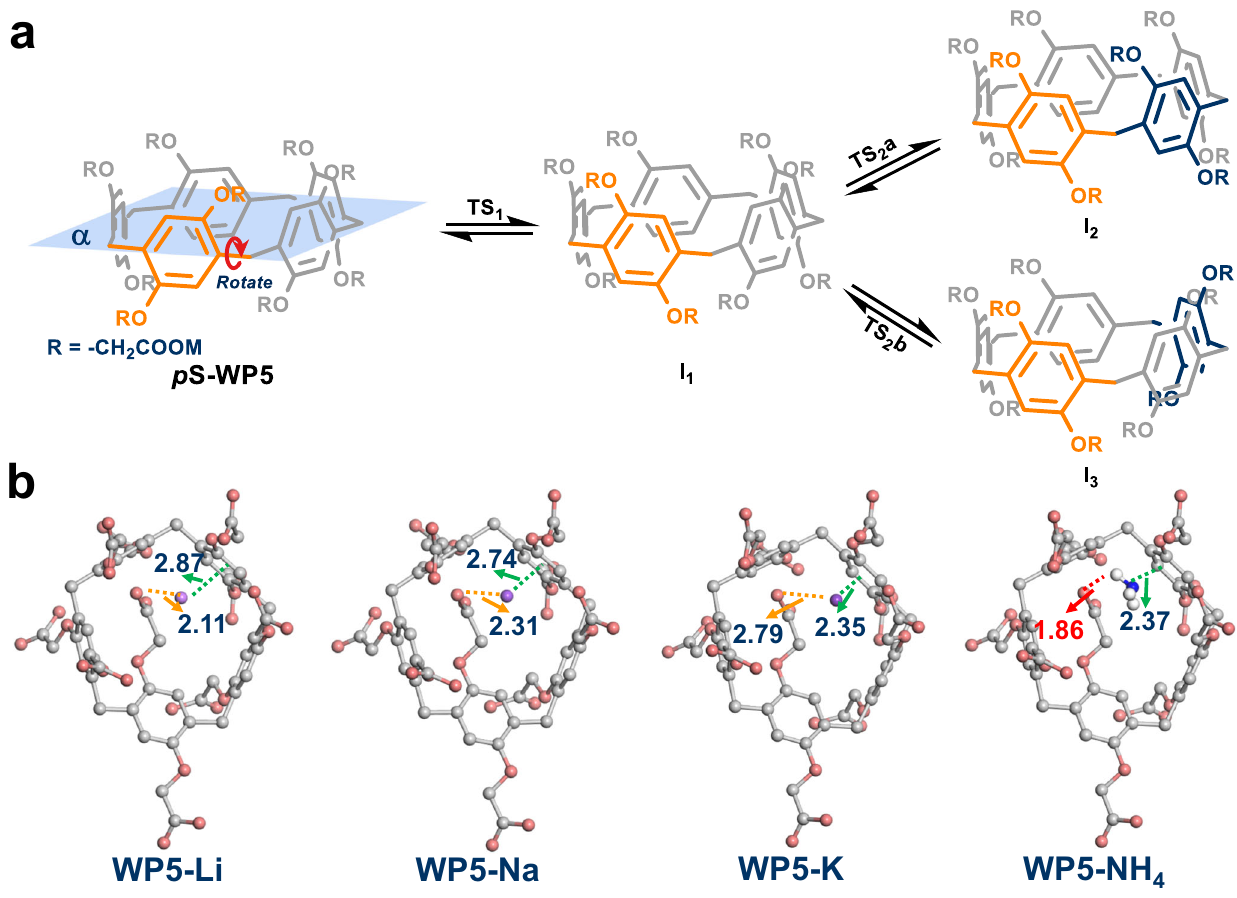
Fig. 5 | Mechanism studies of rotation process of WP5-M. a Partial pathways of transformation between its p S and p R conformers of WP5-M . b Con fi gurations extractedfrompotentialenergysurfacescanningwhenhydroquinoneringrotated